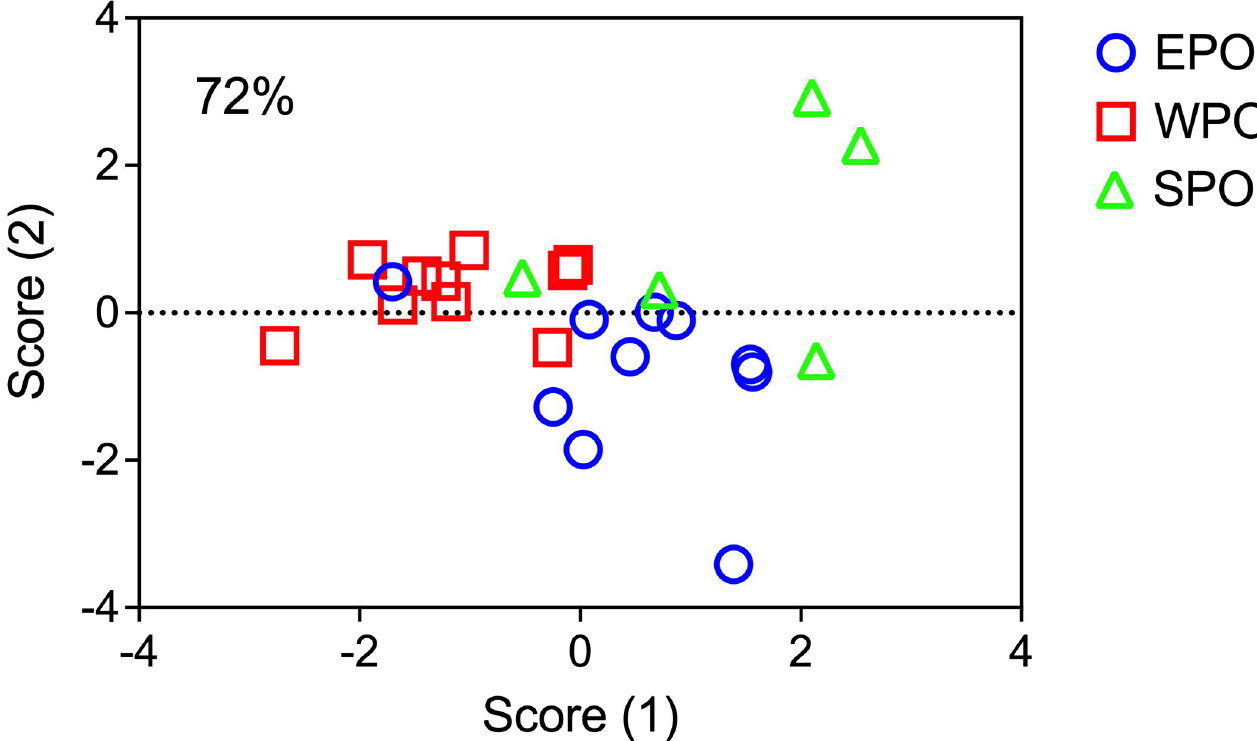
Fig 5. Quadratic discriminant function analysis canonical score plot. EPO = blue circle, WPO = red square, SPO = green triangle. The overall classification accuracy using Pacific bluefin tuna otolith edge Zn:Ca, Sr:Ca and Ba:Ca was 72%.